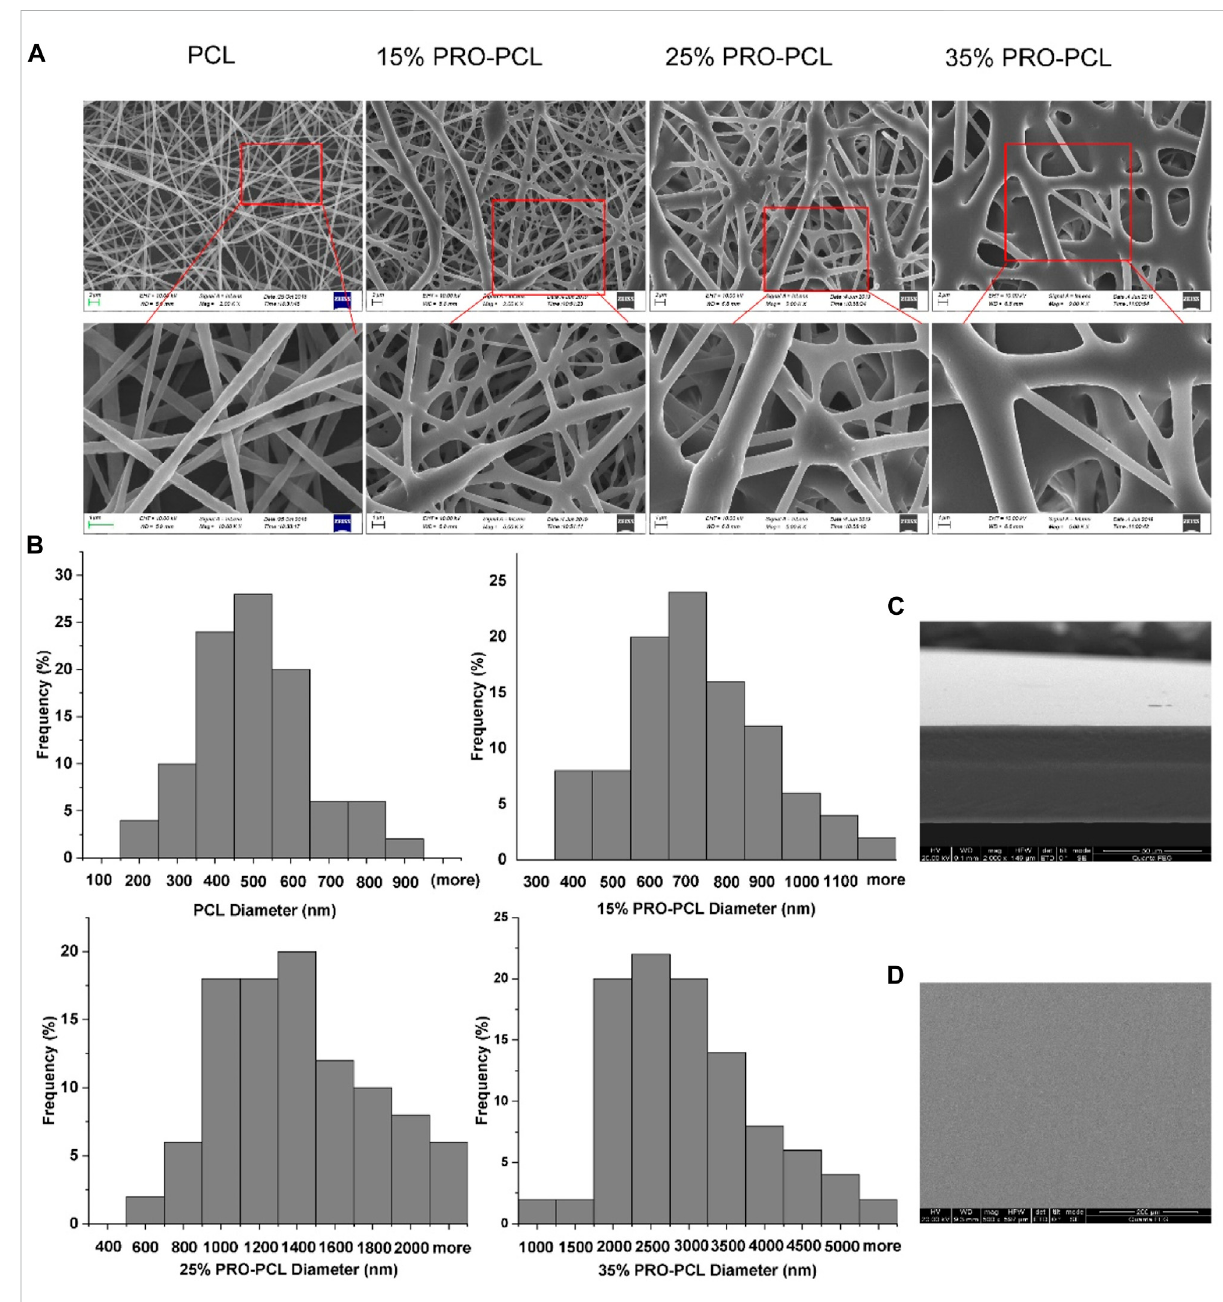
FIGURE 1 SEMimageofthe fi bermembraneandcast fi lm. (A) PRO-PCL fi bermembranes; (B) FrequencydistributionofPRO-PCLnano fi berdiameters; (C) Cross-section of CTS-PVA cast fi lm; (D) Surface of CTS-PVA cast fi